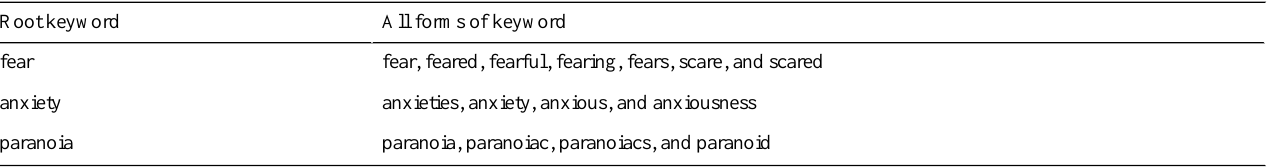
Table 1. All terms related to fear, anxiety, and paranoia.